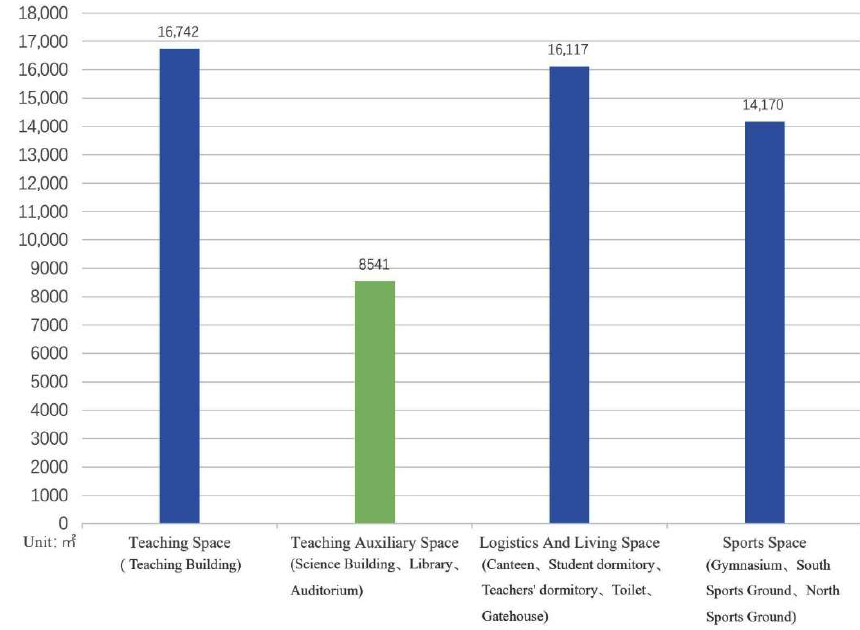
Figure 17. Statistics of the construction area ofJinling High School (source: author).